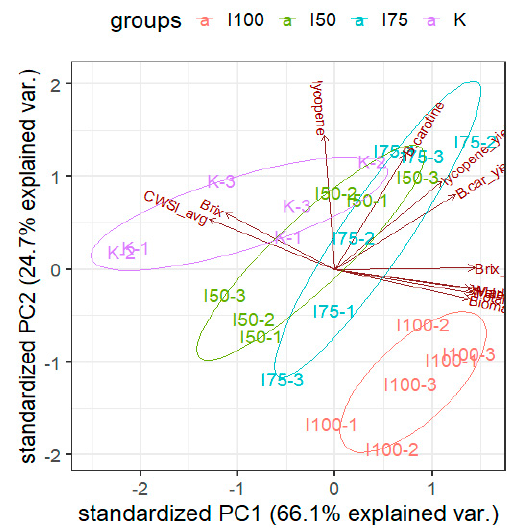
Figure 2. Biplot made from the results of the PCA (n = 3). The different water supply groups are shown with different colors. The different water supply levels are labeled on the plot in mm. The colored are shown with di ff erent colors. The di ff erent water supply levels are labeled on the plot in mm. ellipses’ enclosing the water supply groups. Arrows show how the factors affect the principal The colored ellipses’ enclosing the water supply groups. Arrows show how the factors a ff ect the components. principal